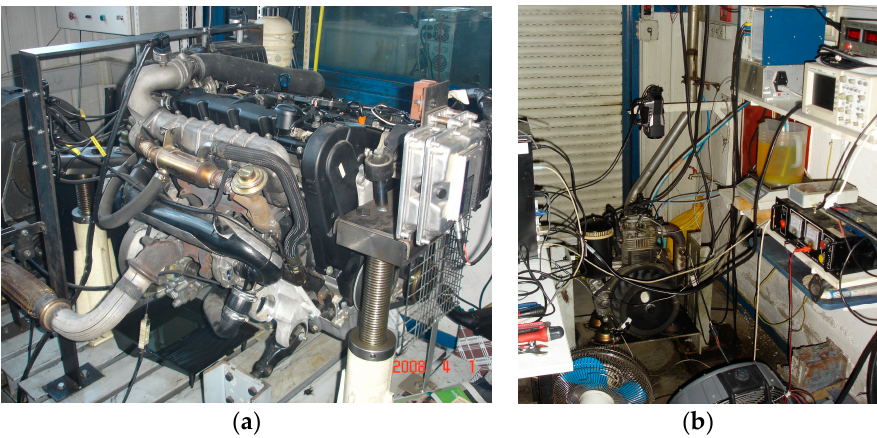
Figure 3. Engine test beds: ( a ) PSA DW10 ATED, ( b ) Ruggerini RF91. Table 2. PSA DW10 ATED engine specifications.